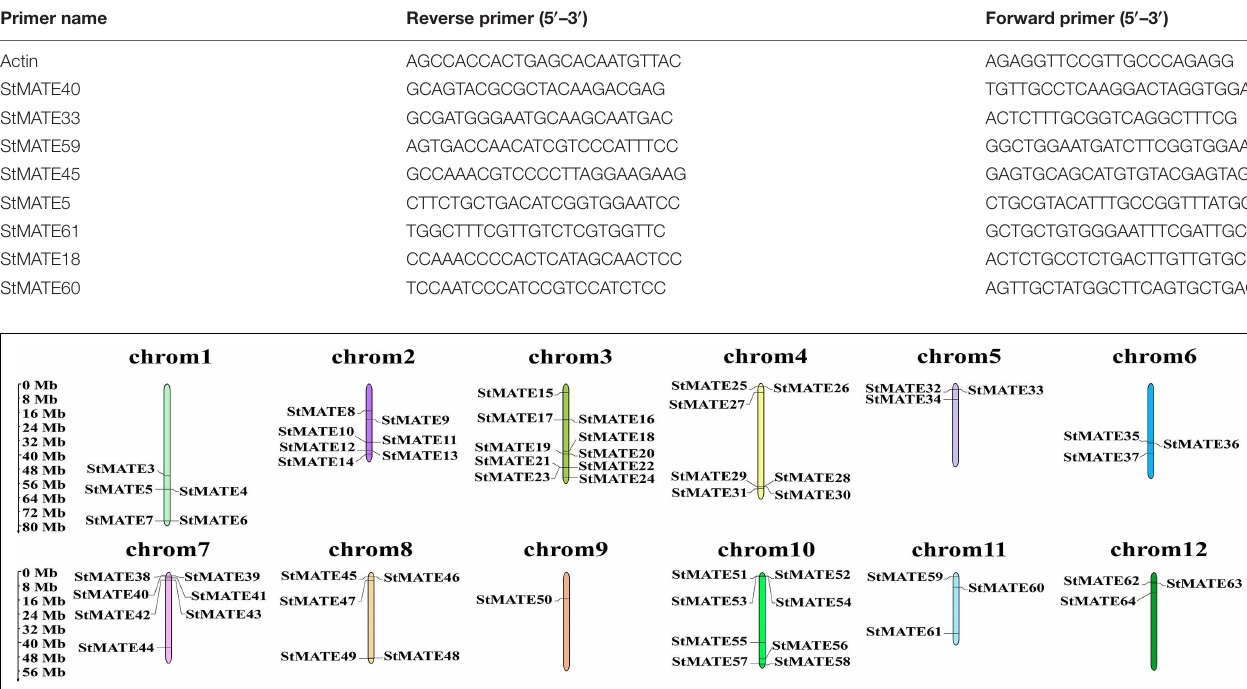
(qRT-PCR). The eight selected StMATE genes are, respectively, StMATE33 / 40 (I), StMATE45 / 59 (II), StMATE5 / 61 (III), and StMATE18 / 60 (IV). Primer Premier 6 was used to design the qRT-PCR primers for the eight MATE genes ( Table 2